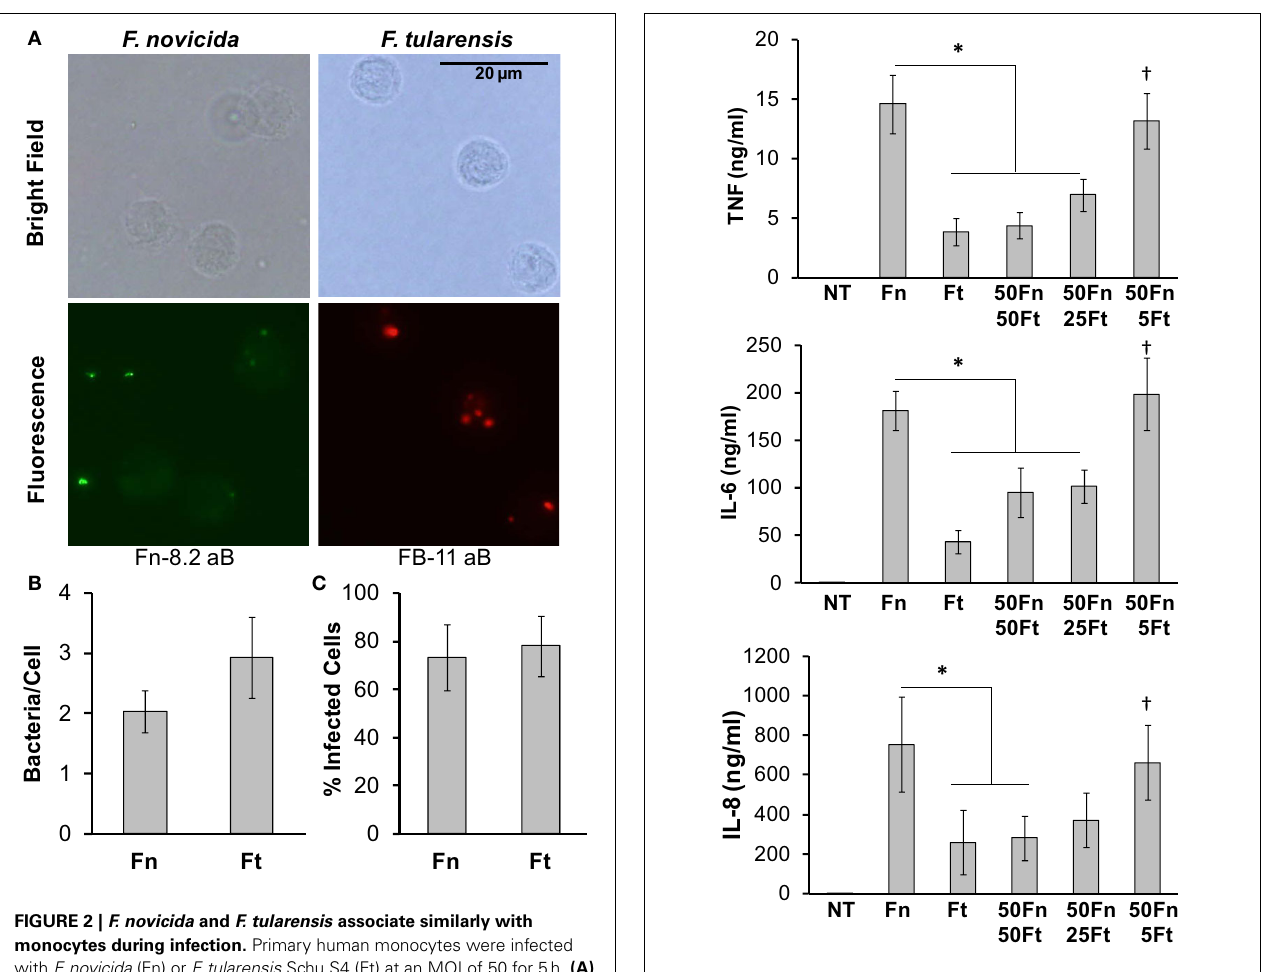
FIGURE 3 | F. tularensis mediates immune suppression in a dose-dependent manner. Primary human monocytes were left untreated (NT) or infected overnight (16h) with F. novicida (Fn), F. tularensis (Ft), or a combination of the two. Ft MOI was administered at decreasing levels (50, 25, and 5 MOI) while keeping Fn MOI constant at 50. Cell-free supernatants were assayed by sandwich ELISAs for TNF- α , IL-6, and IL-8. Graphs represent the mean ± s.e.m. from 4 independent donors. Data were analyzed by ANOVA. ∗ p < 0 . 05 (Fn vs. selected groups), † p < 0 . 01 compared to